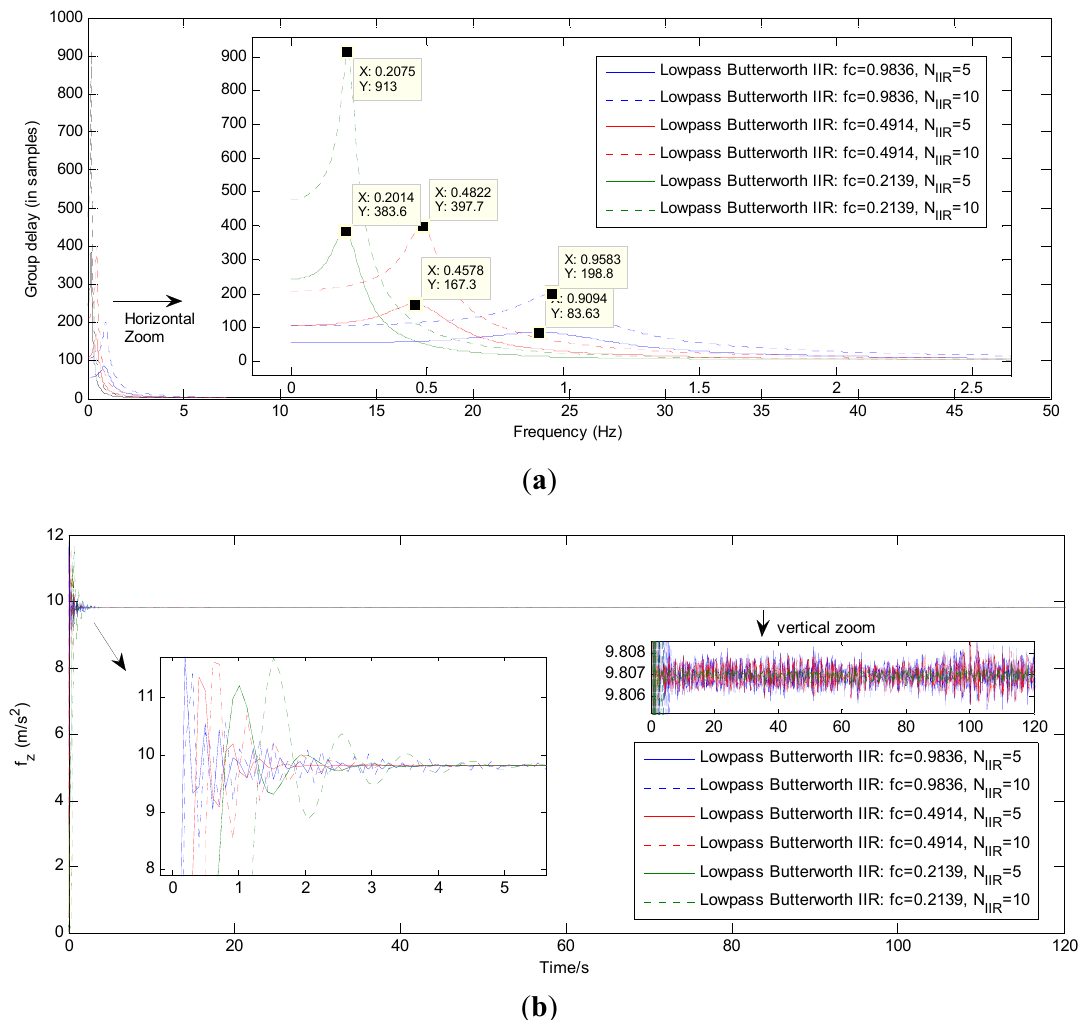
and orders in broad-band c and orders. c